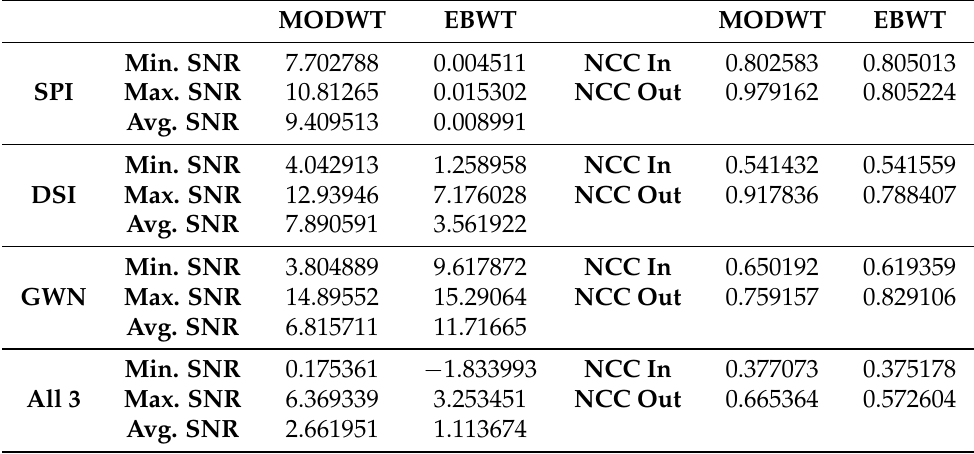
Table 1. ∆ SNR values and average values of normalized correlation coefficient for both MODWT and